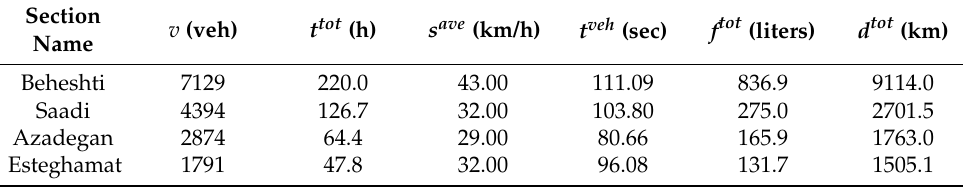
Table 9. SimTraffic performance indicators for the selected roadway